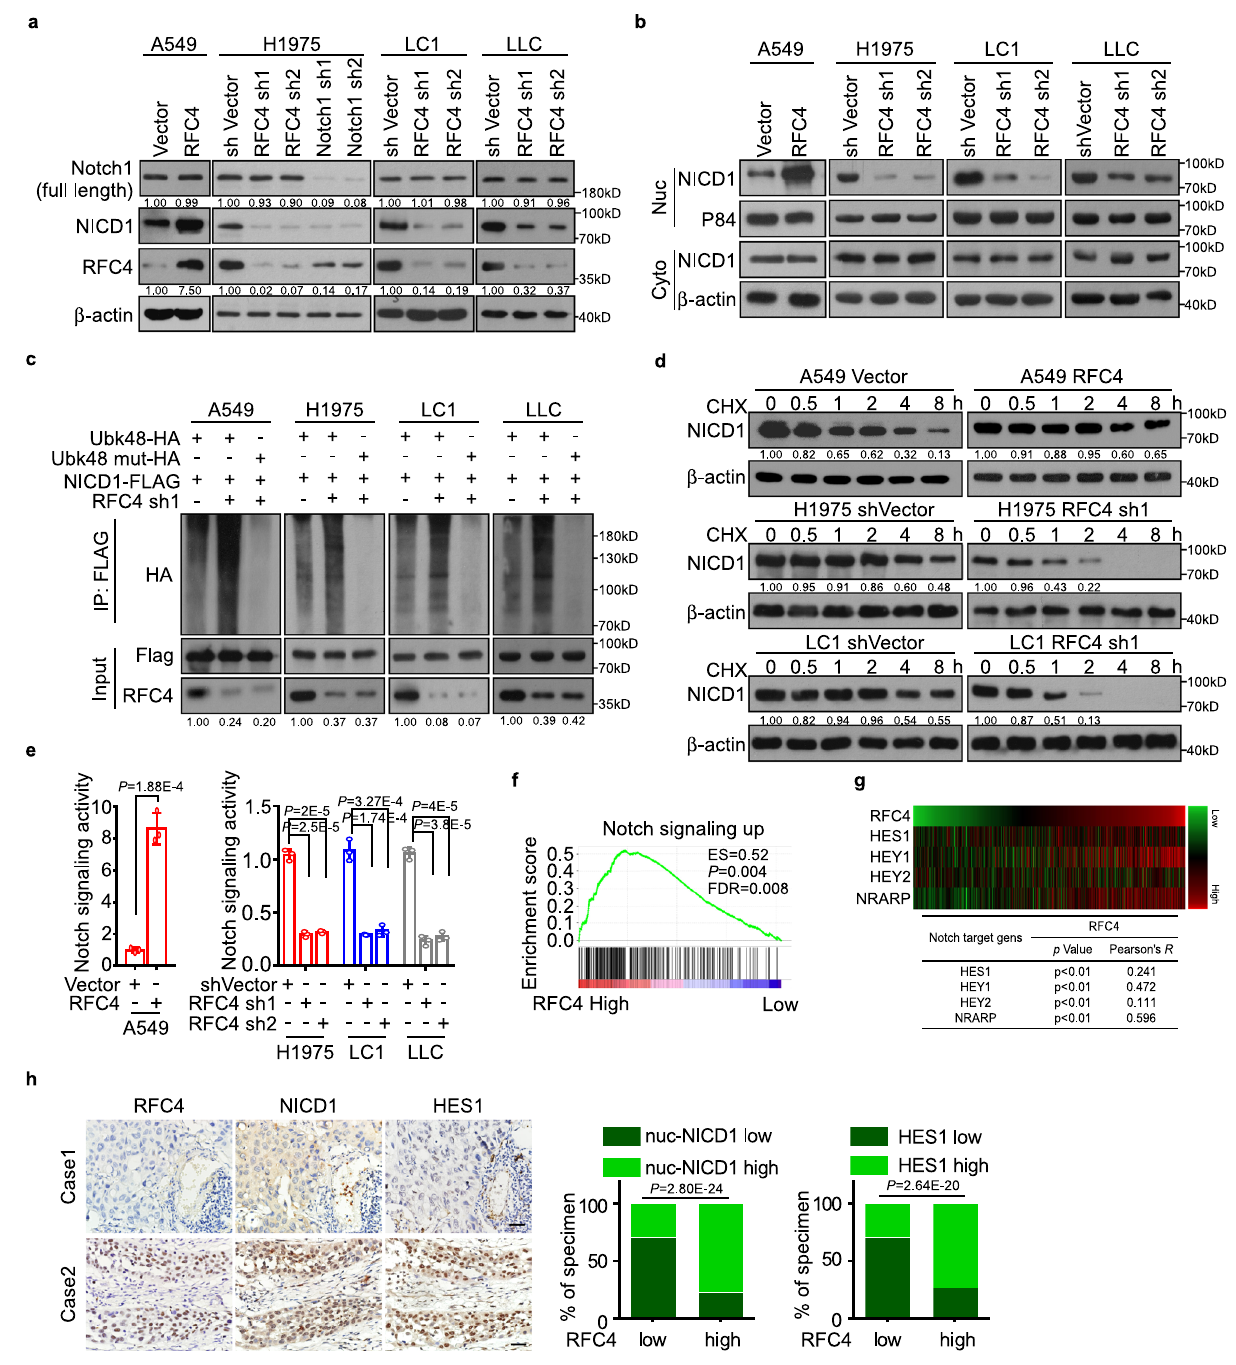
Fig. 4 RFC4 promotes NICD1 protein stability to form a positive feedback loop. a , b WB analysis of full-length Notch1, total NICD1, and subcellular distribution of NICD1 in indicated cells. c The effect of silencing RFC4 on the levels of K48-linked polyubiquitination of NICD1 was evaluated by immunoprecipitation of FLAG-tagged NICD1 in A549, H1975, LC1, and LLC cells. A dominant-negative mutant form of HA-tagged ubiquitin (UbK48R-HA) was used as a negative control. d The effect of overexpressing RFC4 on the half-lives of NICD1 in A549 cells and silencing RFC4 on the half-lives of NICD1 in H1975 and LC1 cells treated with cyclohexamide (CHX). e Dual-luciferase assays revealed Notch signaling activities in indicated cells. f GSEA analysis of the TCGA lung cancer datasets shows correlation between RFC4 and Notch signaling up signatures. g Pearson correlation analysis of the RNA-seq data of 971 NSCLC tissues in the TCGA lung cancer datasets showed the correlation between RFC4 expression and HES1, HEY1, HEY2, and NRARP levels. h Representative IHC staining images of two cases for RFC4, NICD1, and HES1 in the same set of consecutive NSCLC tissue slices, and correlations between RFC4 expression and levels of nuclear NICD1 and HES1 in 219 cases of NSCLC specimens are shown. Scale bar: 20 μ m. Representative images of three independent reproducible experiments are shown ( a – d ). Data in panel e , f , h are presented as mean ± SD derived from three independent experiments. Two-way ANOVA multiple comparison analysis ( e ), two-tailed Student ’ s t -test ( g ), and cross-tabulation with two-tailed Chi-square test ( h ) was used for statistical analysis. Source data are provided as a Source Data fi le.